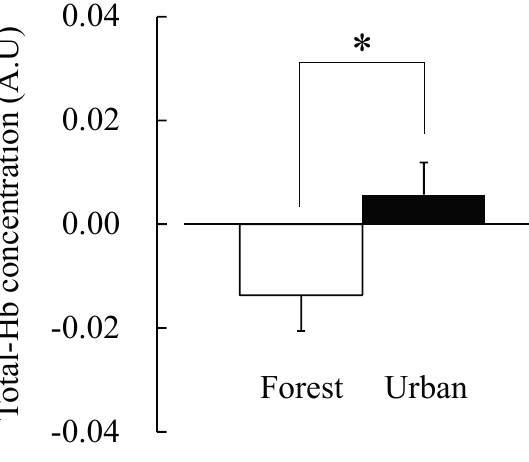
Figure 2. Comparison of the total-Hb concentration of subjects viewing forest and urban areas. N = 7, mean ± SE, * p < 0.05, determined by paired t